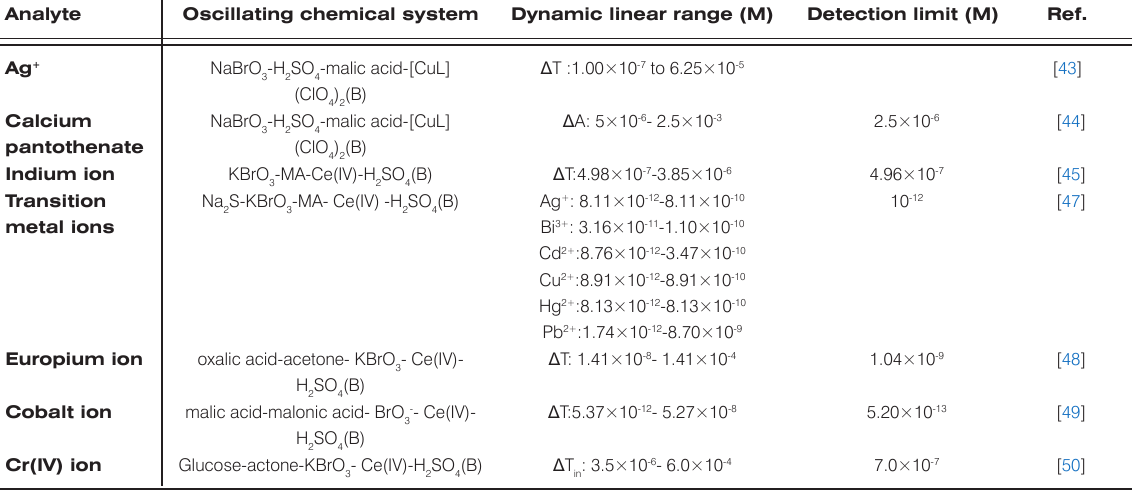
Table 3. Use of regular oscillation in metal ion determination.